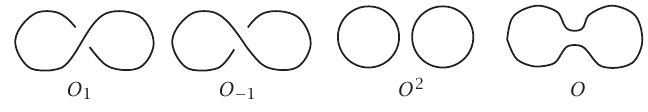
Figure A.6 . Link diagrams used to determine (cid:26) F(O)